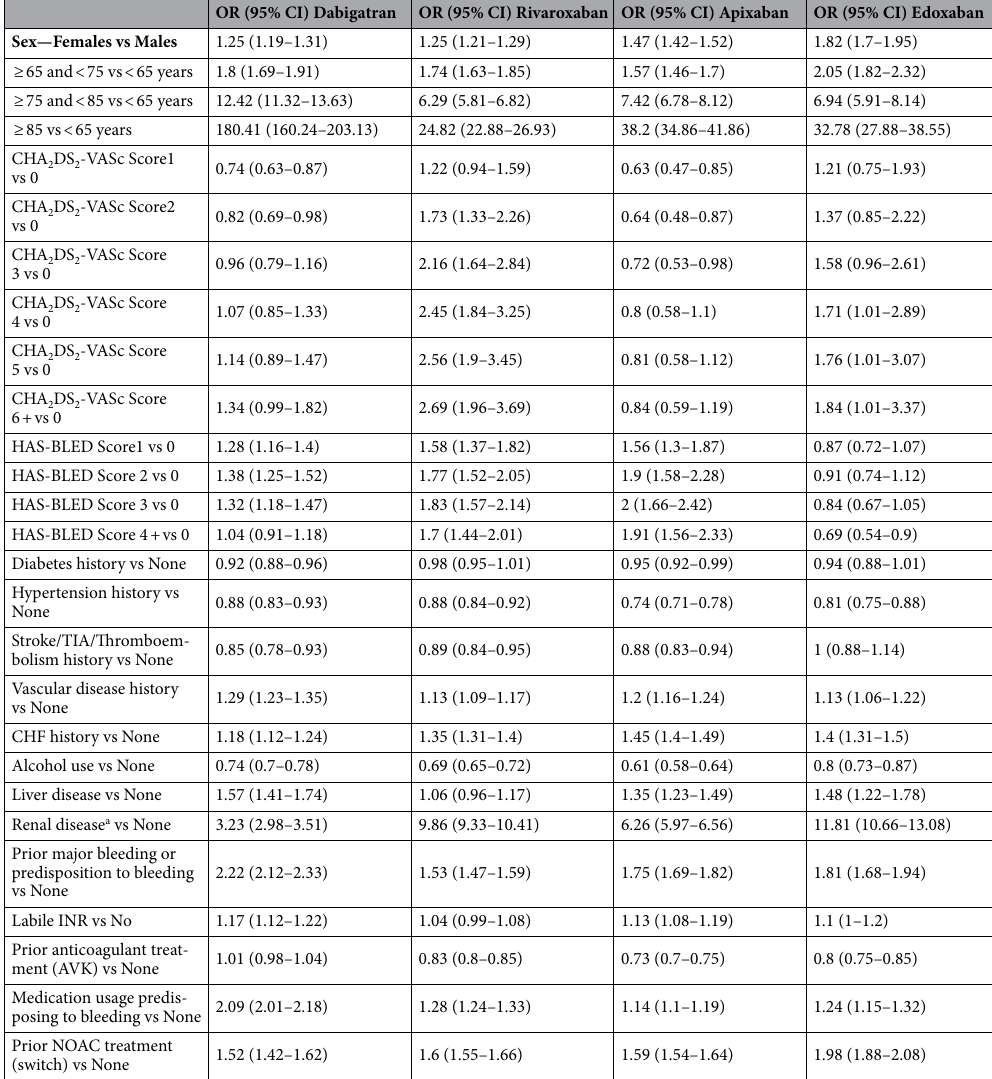
Table 2. Association between baseline characteristics and choice of reduced dose at first prescription in 927,523 NOAC treatments in AIFA Registry (2013–2018). Data are expressed as odds ratio and confidence intervals for the baseline characteristics for each NOAC. a Renal disease = renal transplantation or dialysis or plasma creatinin > 200